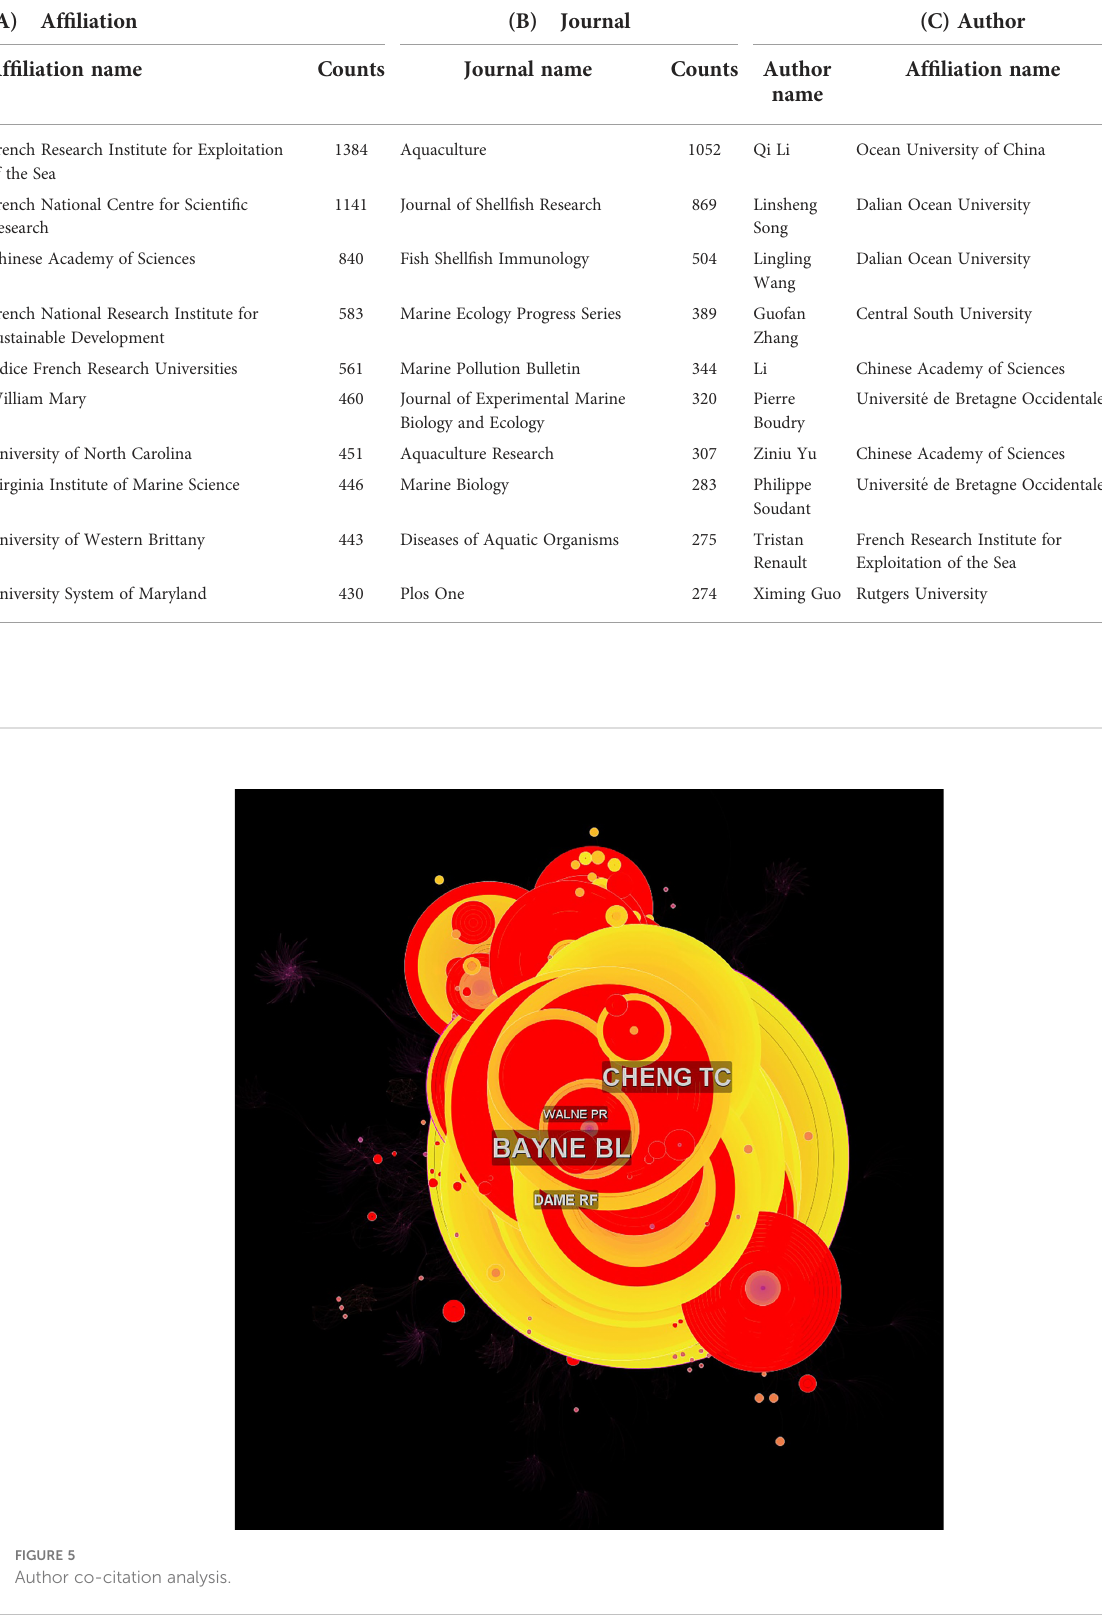
TABLE 1 Top ten contribution (i.e. author, journal and af fi liation) of oyster research in the world, based on the Web of Science Core Collection.